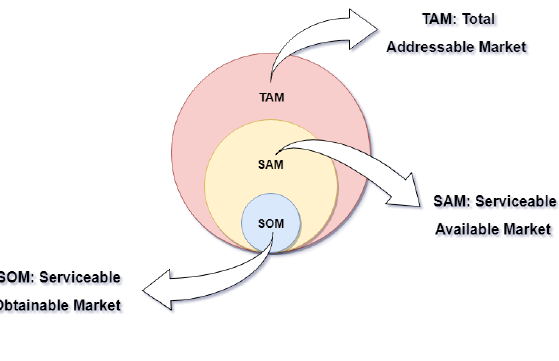
Figure 1: TAM, SAM, and SOM concepts